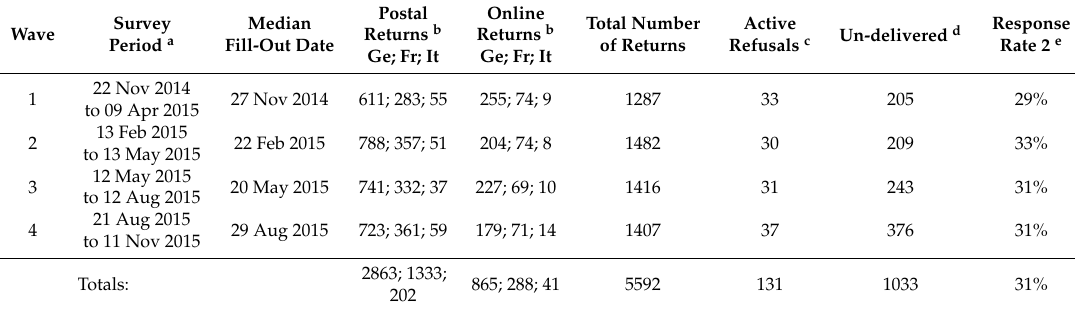
Table 1. Survey response